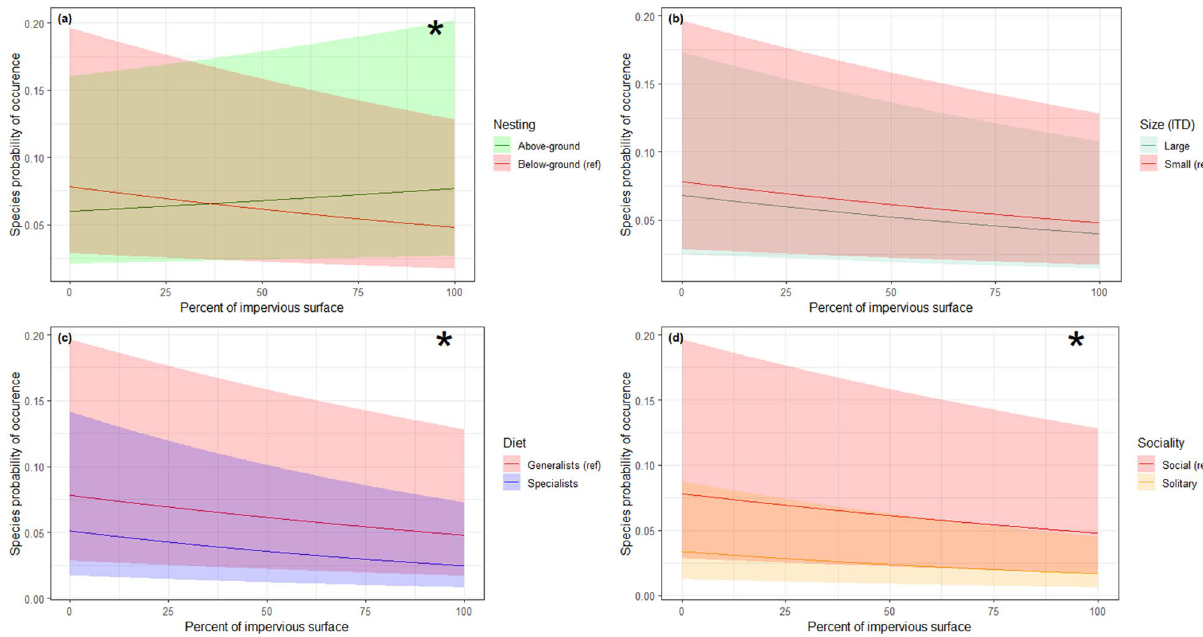
Figure 4. Bee species probability of occurrence as a function of the percent of impervious surface and functional trait modalities. Model predictions are plotted separately by trait modalities, so as to highlight the statistical interactions that may support an ecological filter hypothesis, i.e. different slopes between two modalities of a given trait. In each panel, the reference modality handled by the model (red curves, with a “ref” legend tag) was chosen on the basis of the most abundant species in the dataset, namely Lasioglossum malachurum , a small-sized species nesting below ground, with generalist diet and social habits. Shaded areas stand for the 95% confidence interval of these predictions. The plots labelled with an asterisk indicate a significant trait modality-percent of impervious surface